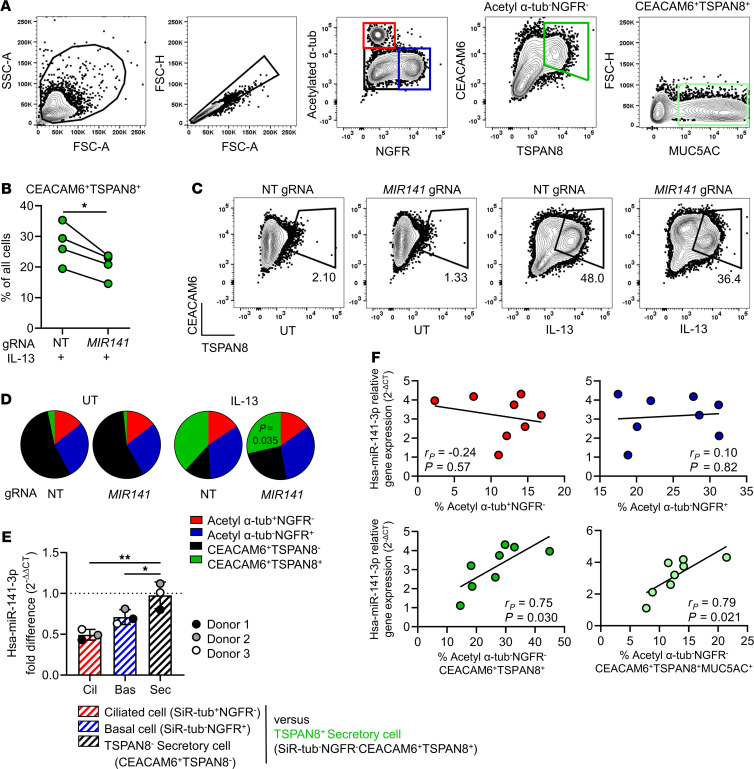
miR-141 repression in gene-edited airway epithelial cells is associated with a reduction in mucus-producing goblet cell numbers.(A) Flow cytometry gating strategy of acetylated α-tubulin+NGFR– (red gate, ciliated cells), acetylated α-tubulin–NGFR+ (blue gate, basal cells), acetylated α-tubulin–NGFR–CEACAM6+TSPAN8+ (green gate, secretory cells), and acetylated α-tubulin–NGFR–CEACAM6+TSPAN8+MUC5AC+ (light green gate, MUC5AC+ secretory cells) cells. (B) Frequency of acetylated α-tubulin–NGFR–CEACAM6+TSPAN8+ secretory cells (% of all cells, n = 4/group) in human bronchial epithelial cell (HBEC) cultures that have undergone gene editing with nontargeting (NT) or MIR141-targeting gRNAs, subsequently grown at air-liquid-interface (ALI) with IL-13 stimulation (2-tailed paired t test). (C) Representative contour plots demonstrating CEACAM6+TSPAN8+ secretory cells in ALI cultures of untreated (UT, left) or IL-13–stimulated (right) HBECs after gene editing with NT or MIR141 gRNAs. (D) Frequency of ciliated cells (red), basal cells (blue), TSPAN8– secretory cells (black), and TSPAN8+ secretory cells (green) (% of all cells, n = 4/group) in ALI-cultured NT or MIR141-targeted HBECs with (IL-13) or without (UT) IL-13 (2-tailed paired t test). (E) Hsa-miR-141-3p expression fold difference assessed by TaqMan qPCR in FAC-sorted ciliated cells (SiR-tubulin+NGFR–), basal cells (SiR-tubulin–NGFR+), and TSPAN8– secretory cells compared with IL-13–inducible TSPAN8+ secretory cells (1-way ANOVA followed by Dunnett’s test; *P < 0.05, **P < 0.01). (F) Hsa-miR-141-3p expression levels assessed by TaqMan qPCR in relation to frequency of red, blue, green, or light green cell gates (as in A). rP, Pearson correlation coefficient.